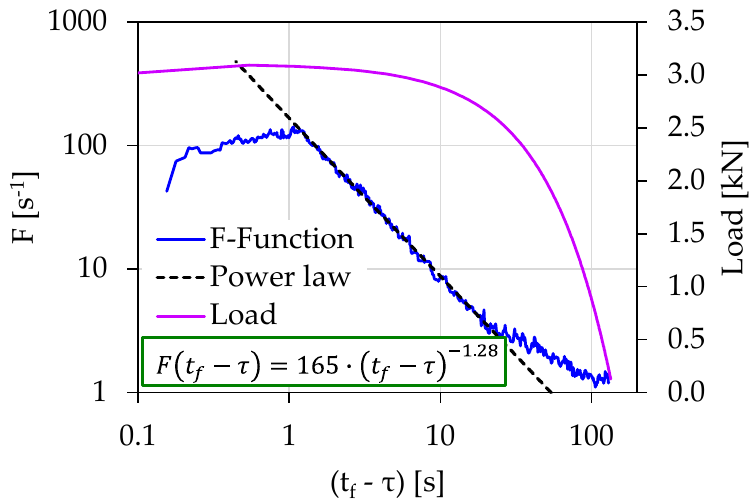
Figure 9. The temporal evolution of the F -function in juxtaposition to the load applied for the experiment Exp-LR2 in terms of the “time-to-failure” parameter.